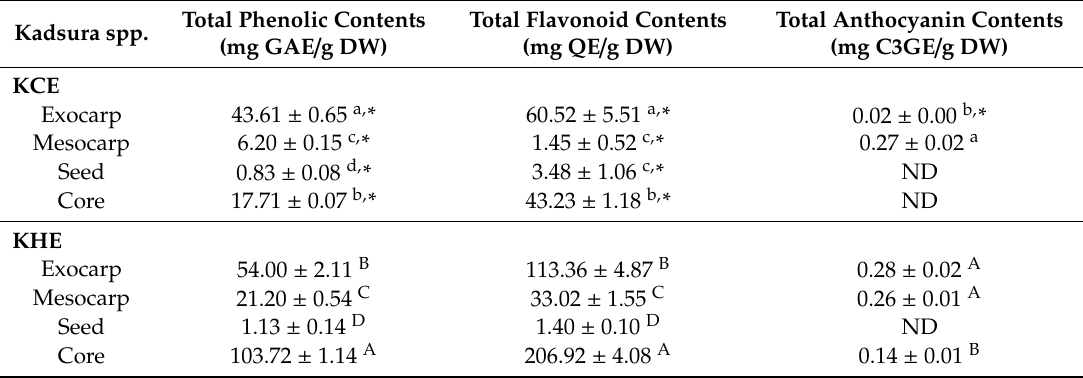
Table 3. Quantification of the total phenolic contents (TPCs), total flavonoid contents (TFCs), and total anthocyanin contents (TACs) in di ff erent fruit parts of Kadsura coccinea (Lem.) A.C. Sm. extract (KCE) and Kadsura heteroclita (Roxb.) Craib extract (KHE). Kadsura